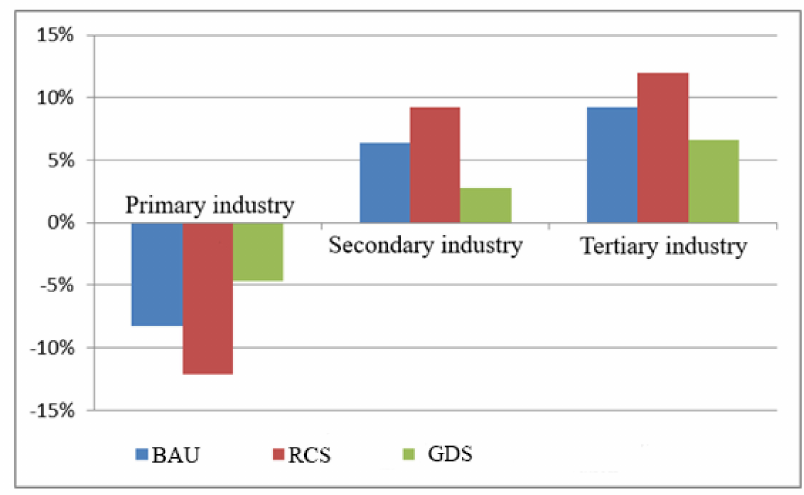
Figure 7. Change of three main industries’ land demand in different scenarios.